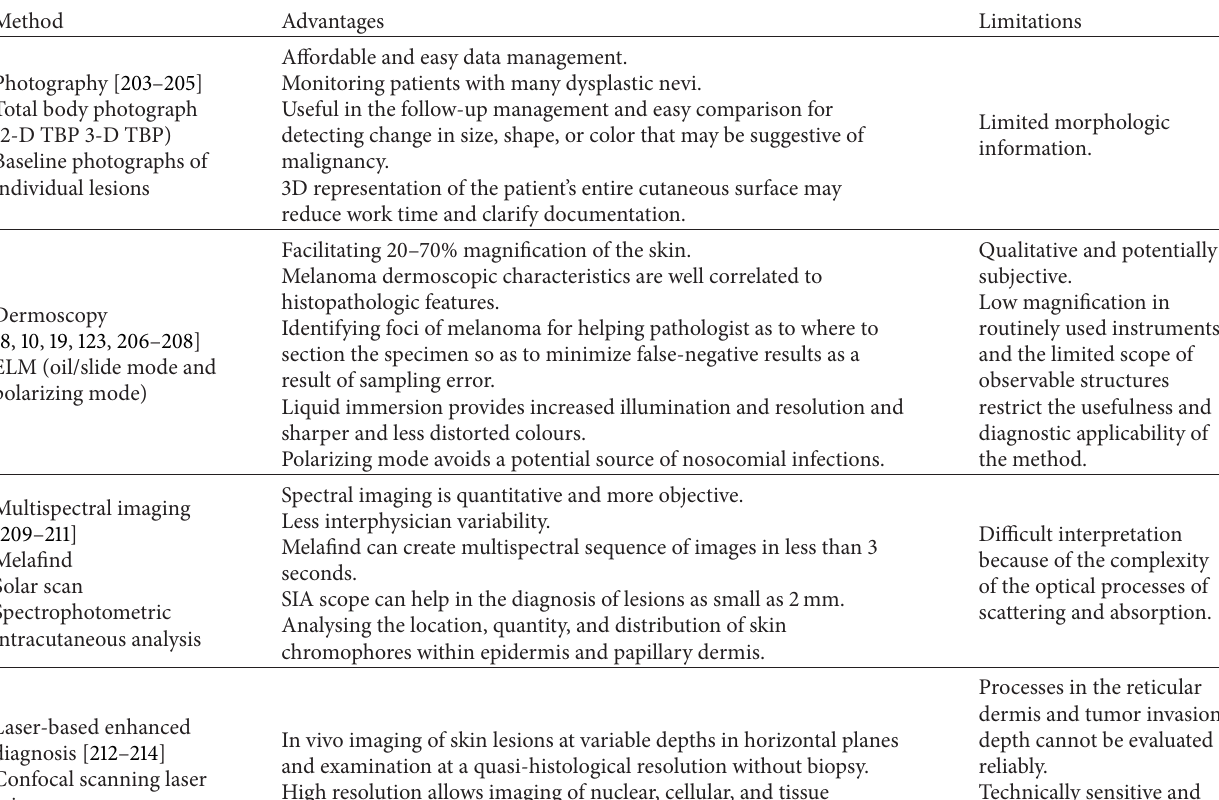
Table 1: In vivo imaging techniques for the diagnosis of skin